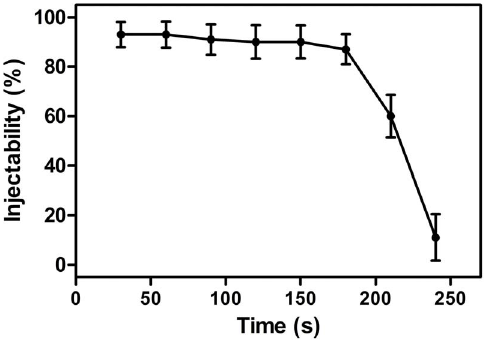
Figure 1. Percent injectability of vancomycin-loaded borate bioactive glass (BG) cement as a function of time after mixing.